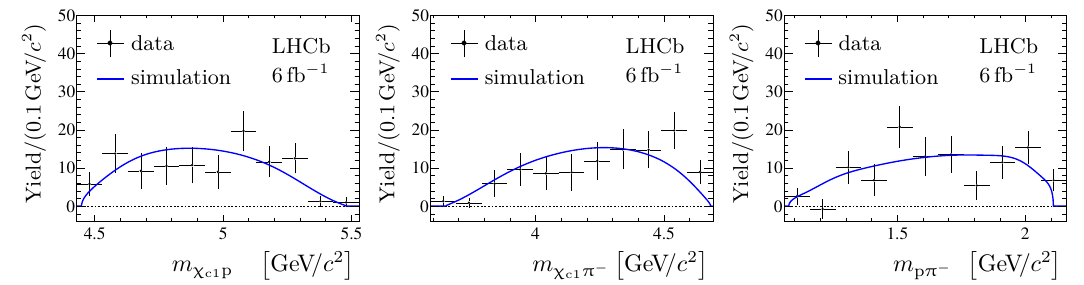
Figure 3 . Background-subtracted mass distributions of the (left) (cid:31) c1 p , (centre) (cid:31) c1 (cid:25) − and (right) p (cid:25) − combinations in the Λ 0 → (cid:31) c1 p (cid:25) − decay. Expectations from a phase space simula- b tion are